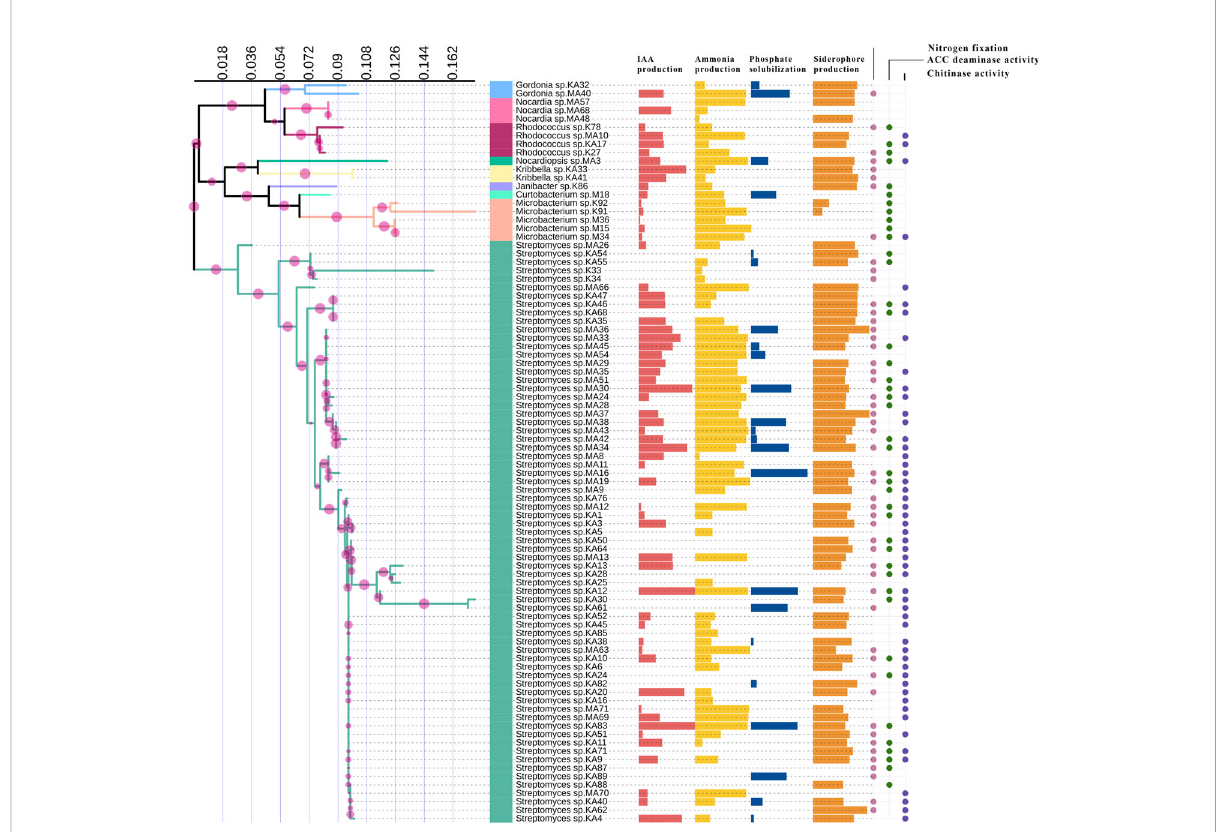
FIGURE 3 Comparison of PGP traits among different taxa of endophytic actinobacteria isolates. IAA production, ammonia production, phosphate solubilization, and siderophore production are represented by horizontal bars; circles represent the qualitative presence or absence of nitrogen fi xation, ACC deaminase, and chitinase